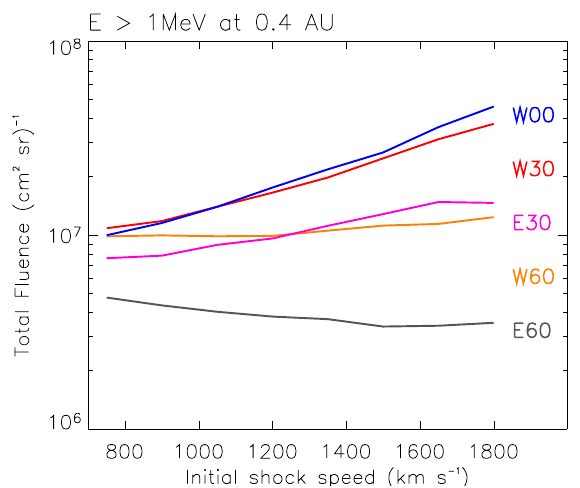
Fig. 4. Total fluence of protons above 1MeV as a function of the initial shock speed and the heliolongitude, for observers located at 1 AU. For simplicity, the plot only shows 6 cases (color coded) among the 14 possible heliolongitudes. These values of the total fluence are the averaged values of the total fluence corresponding to the four possible transport conditions, variables [4] and [5], for each initial shock speed and heliolongitude.